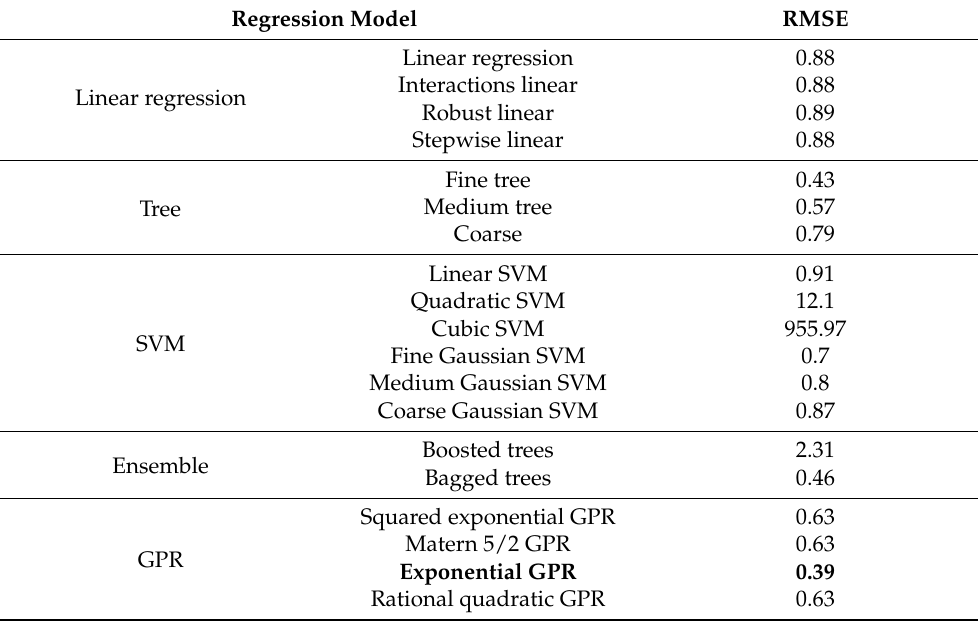
Figure 5. ( a ) Sensor values from the ventilation experiment and ( b ) its Regression Model. Table 3. Outcomes of experiments on Machine Learning models: Regression Models to predict the correlating changes in Gas Sensor values.